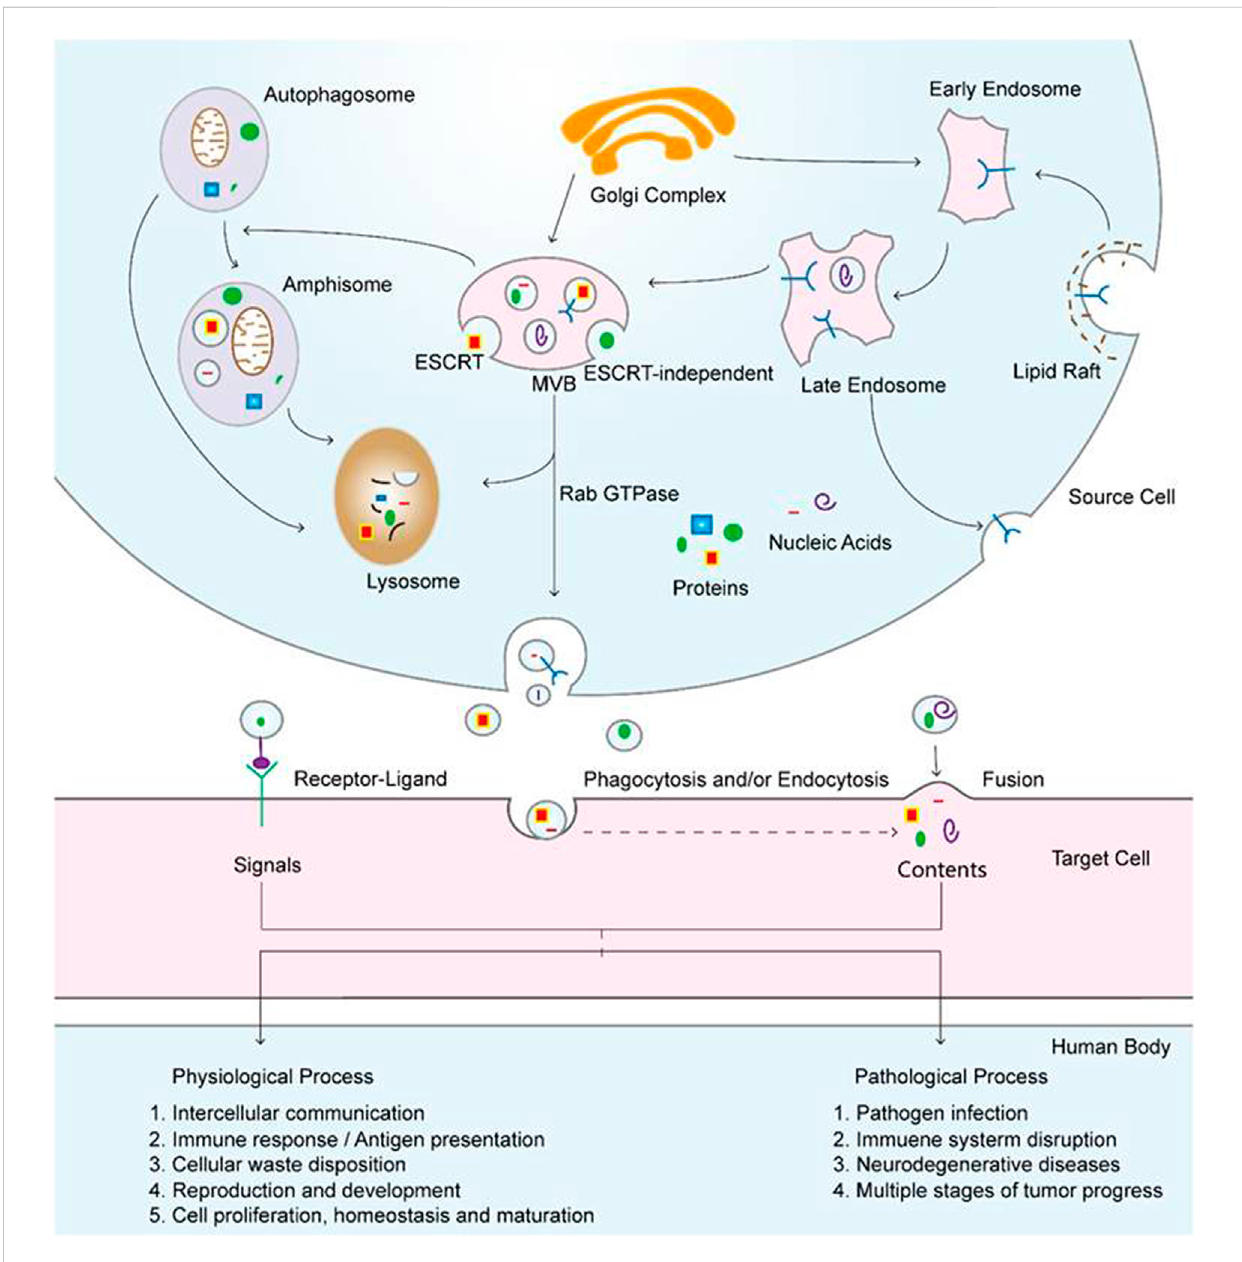
FIGURE 5 Exosomal biogenesis and internalization mechanisms and their roles in physiological and pathological processes. Exosomes are formed by inward budding from the endosomal membrane, which leads to the formation of multivesicular bodies (MVBs). MVBs can be fated for lysosomal degradation or fusion with the plasma membrane, which is associated with the release of exosomes. In addition, MVBs also participate in autophagosome maturation as endocytic fusion partners that meet with autophagosomes. Target cells internalize exosomes by three methods, which can facilitate the signaling and content delivery from source to target cells, thus mediating the progression of many physiological and pathological processes. Reproduced with permission of Ivyspring International Publisher (He et al.,